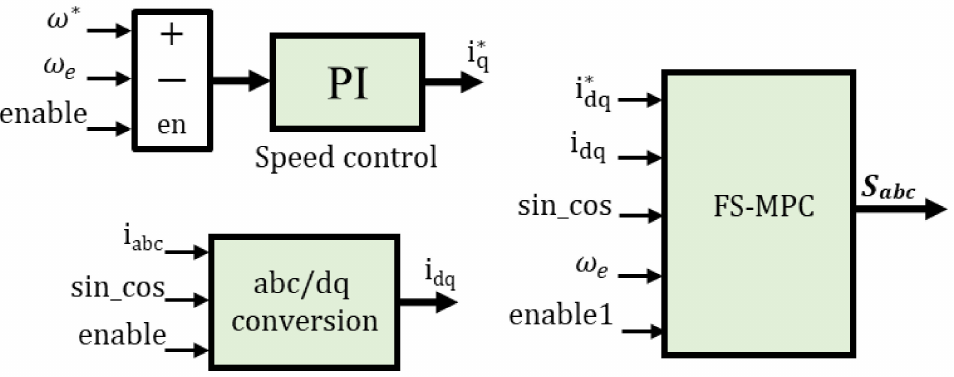
Figure 8. Controller implementation in the FPGA.